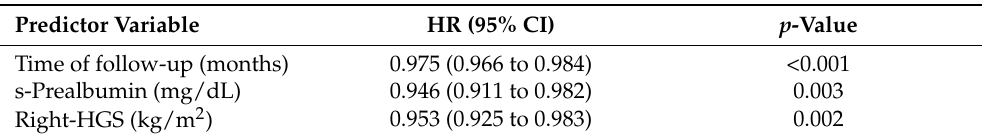
Table 4. Multivariate Cox proportional hazards analysis of all-cause mortality risk in stage 3b, 4–5 chronic kidney disease